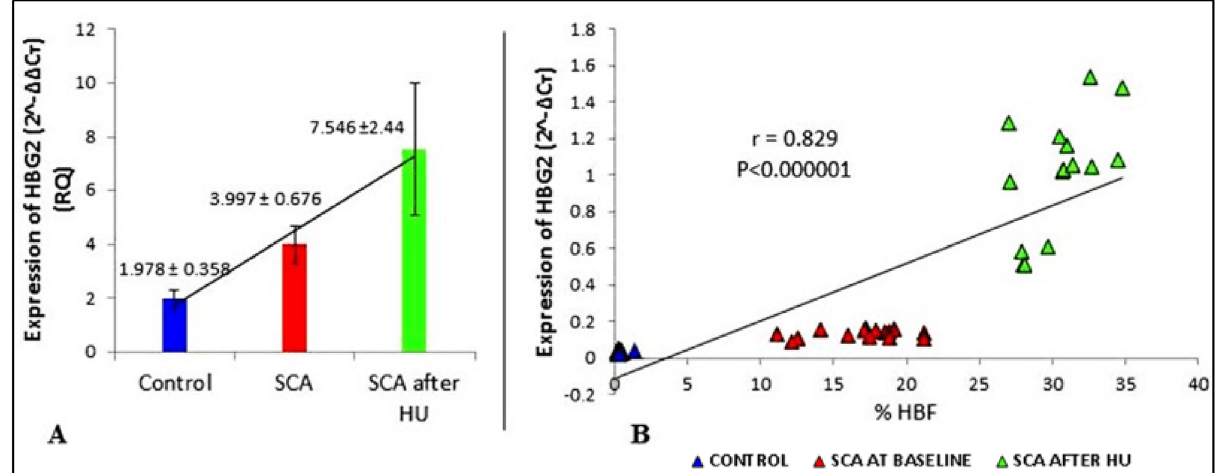
Figure 1. Relative quantification of γ-globin gene expression before and after hydroxyurea and its correlation with HbF levels. ( A ) The relative quantification (RQ) (2 ^−∆∆CT ) showing fold increase in γ-globin (HBG2) expression after HU Therapy in (n = 30) SCD patients. ( B ) Spearman’s Correlation Analysis between HbF levels and γ-globin (HBG2) expression. **Significant at p ≤ tried to correlate HBG2 expression with % HbF and found a strong positive correlation (Spearman’s correlation coefficient: 0.829) at p < 0.0001 (Fig. 1B).